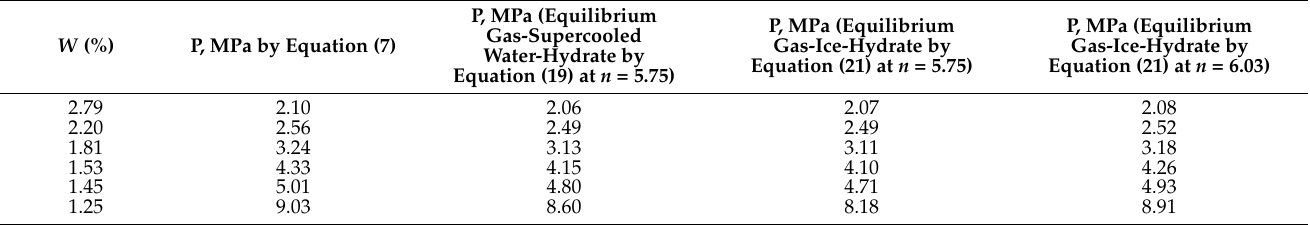
Table 5. Dependence of nonclathrated water content in kaolinite clay on methane pressure at a temperature of 265.65 K by different calculations.